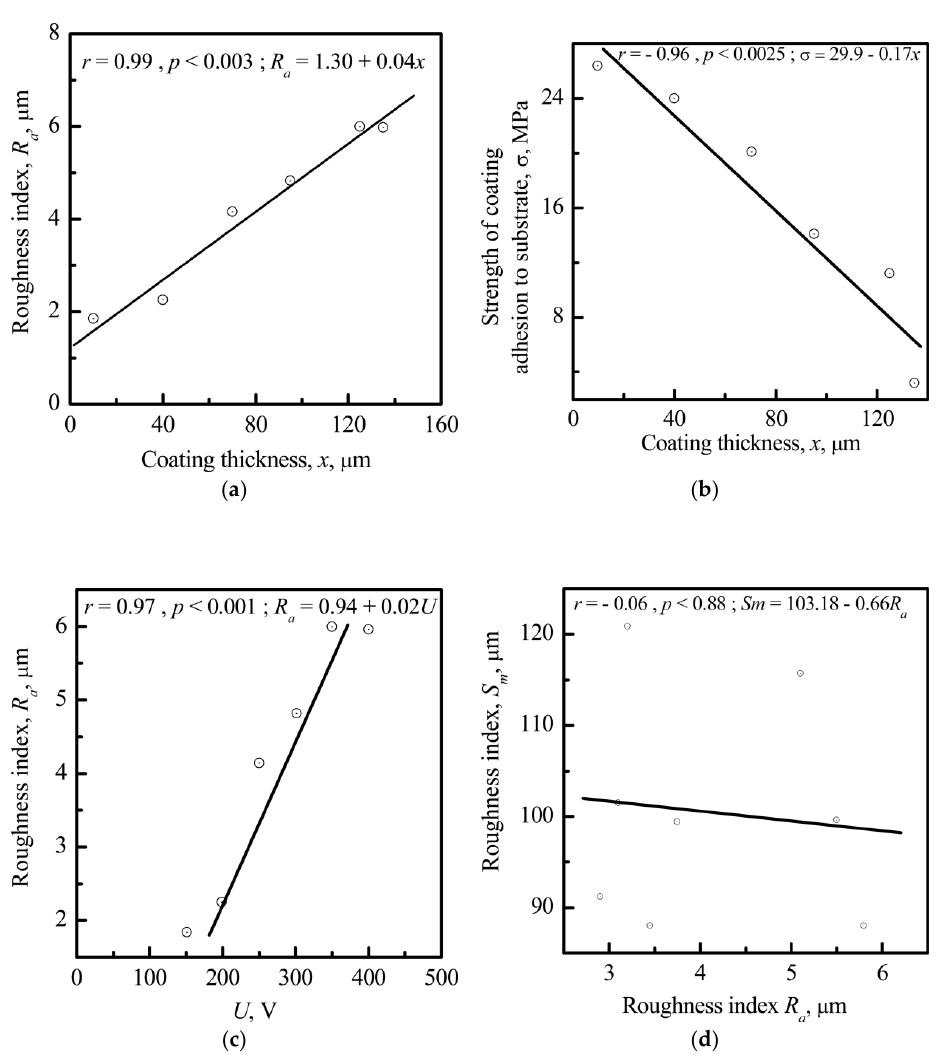
Figure 8. Correlations between ( a ) the CP coating thickness ( x ) and the roughness index R a ; ( b ) the CP coating thickness ( x ) and the adhesion strength of the CP coating to the metal substrate; ( c ) the amplitude of the electrode voltage ( U ) of the microarc device and the roughness index R a ; and ( d ) the CP roughness indices R a and S m .